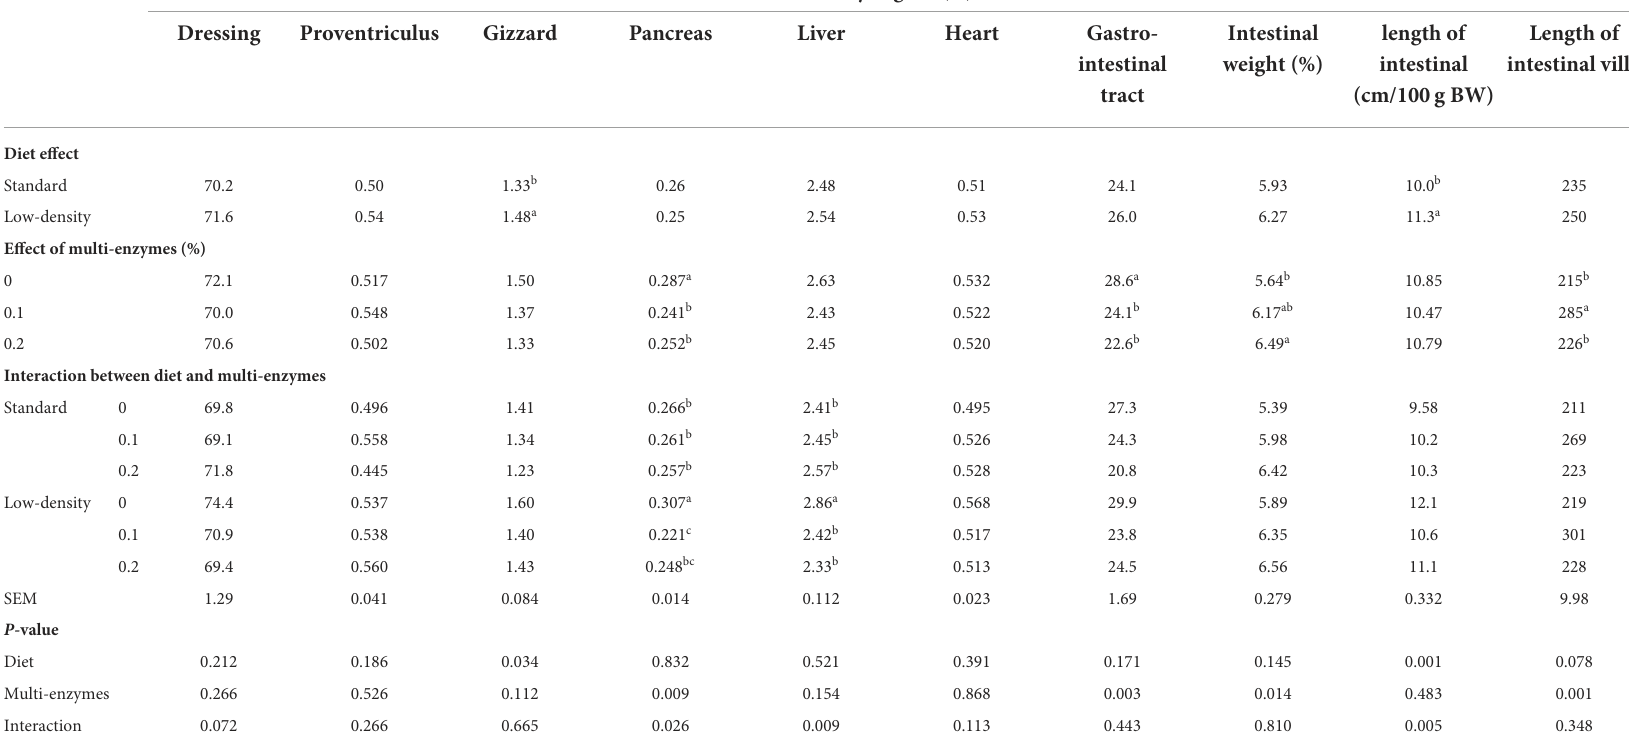
TABLE 4 Carcass traits and relative weights of body organs of 38-day-old broilers fed standard and low-density diets supplemented with different concentrations of multi-enzymes from 1 to 38 days of